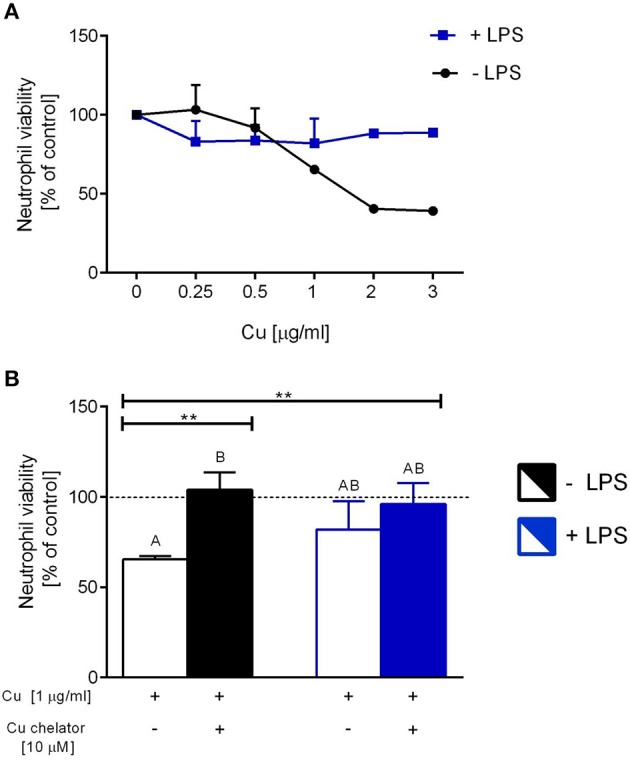
The impact of exogenous copper of neutrophil viability (A), and counteraction of copper effects by its chelating agent (B) in ex vivo conditions. Neutrophils isolated from the bone marrow of C57Bl/6J mice were incubated with various copper concentrations in the presence (+LPS) or absence (–LPS) of lipopolysaccharide (A). Cell viability reversed by the Cu chelator (B). The dotted line (B) indicates values for untreated neutrophils (Cu concentration “0” in A). Asterisks indicate significant differences using unpaired two-tailed Student's t test (**P ≤ 0.01) and one-way ANOVA (post hoc Bonferroni) test (different letters indicate statistically significant differences between groups).